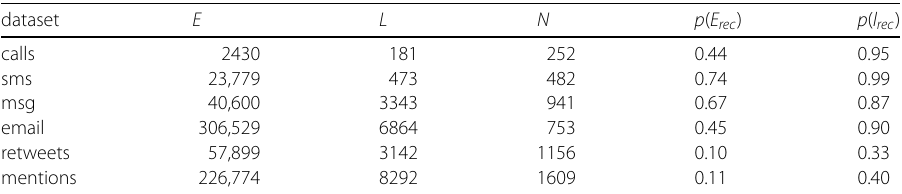
Table 1 Basic statistics of studied datasets. Temporal network data on calls and messages from the Copenhagen Network Study [51, 52] (calls & sms), online social network messages at the University of California, Irvine [53] (msg), emails at a European research institution [54] (email), and our crawl of keyword-restricted retweets and mentions in Twitter (retweets & mentions) (see Additional file 1 Section S2). Table shows the number of events E , links L , and nodes N , as well as the fraction of reciprocations over a link, p ( E rec ), and the fraction of links having at least one reciprocation, p ( l rec ) (see Additional file 1 Section S1). Most channels (apart from Twitter) show significant levels of